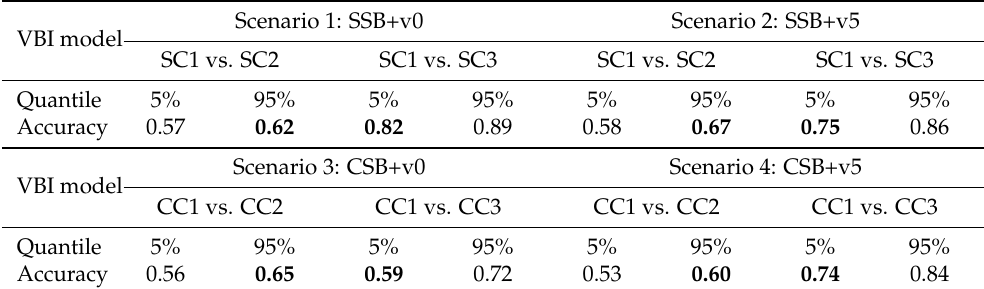
Figure 14. Classification accuracy values using UMAP. Table 6. Quantiles of accuracy values using